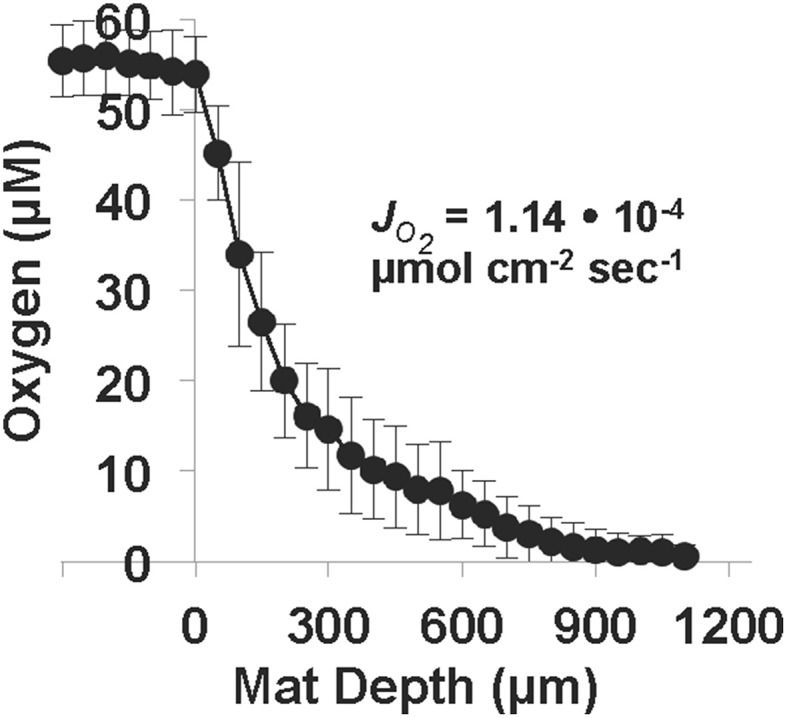
Oxygen microprofiles (n = 11, electrode tip diameter = 50 μm) measured in One Hundred Spring Plain Fe(III)-oxide mats (May 2013; temperature = 75°C, pH = 3.5, O2 (aq) ~55 μM). The diffusive flux of oxygen, JO2, was estimated from the measured concentration profiles as a function of Fe(III)-oxide mat depth. Position zero refers to the aqueous-Fe(III)-oxide mat interface.